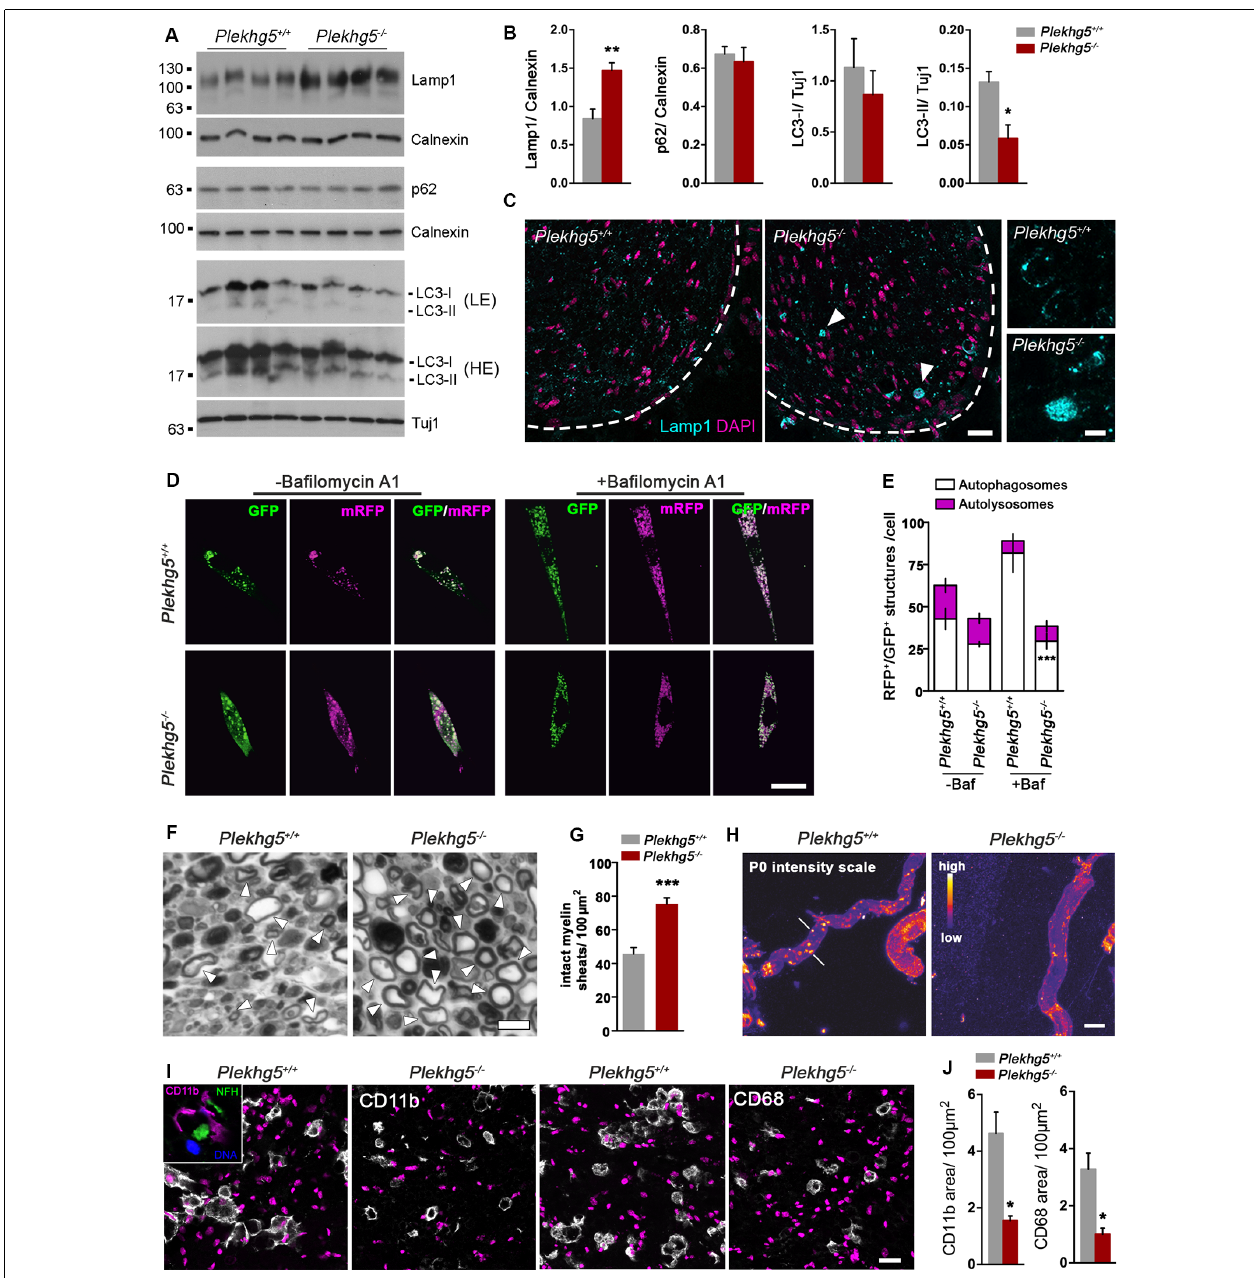
FIGURE 3 | Impairments in Schwann cell autophagy upon Plekhg5 -deficiency. (A) Protein levels of Lamp1, p62, and LC3 in sciatic nerve lysates obtained from 11-month-old mice. LE, low exposure, HE, high exposure. (B) Quantification of Western blots ( n = 5/4 (wild-type/ko), unpaired, two-tailed t -test). (C) Immunohistochemical staining of sciatic nerve cross-section from 12-month-old animals for Lamp1. Overview; scale bar: 50 µ m. Higher magnification; scale bar: 5 µ m. Arrowheads point to accumulations of Lamp1 + organelles. (D) Confocal microscopic analysis of primary Schwann cells transduced with mRFP-GFP-LC3 reporter. To inhibit fusion of autophagosomes with lysosomes, the cells were treated with 400 nM Bafilomycin A1 for 4 h or left untreated prior to fixation. (E) Quantitative analysis of fluorescent structures within transduced Schwann cells. GFP + –RFP + structures were defined as autophagosomes, GFP − –RFP + structures as autolysosomes. At least five cells per experiment were analyzed; three independent experiments ( n = 3, two-way ANOVA with Bonferroni posttest). (F) Representative images of semithin sections of sciatic nerve fragments from wild-type and mutant mice cultivated for 5 days. Arrowheads point to intact myelin sheets. (G) Amount of intact myelin sheaths, normalized to the area of the section analyzed. At least five sections per animal were analyzed; three animals per genotype ( n = 3, unpaired, two-tailed t -test). (H) Immunohistochemical stainings of teased fiber preparations derived from cultivated sciatic nerve fragments against the myelin protein zero (P0). Arrows point to degraded myelin. Scale bar: 10 µ m. (I) Immunohistochemical staining of nerve segment cross-sections for CD11b and CD68. Scale bar: 20 µ m. The inset shows a costaining of NFH and CD11b. (J) Quantification of CD11b and CD68 stainings. Five sections per nerve segment were analyzed; three segments per genotype ( n = 3, unpaired, two-tailed t -test). * p < 0.05; ** p < 0.01; *** p < 0.001.